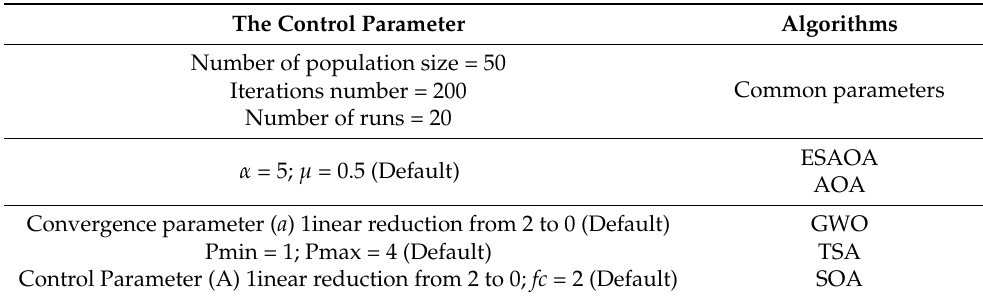
Table 3. The control parameters of the proposed and other techniques. The Control Parameter